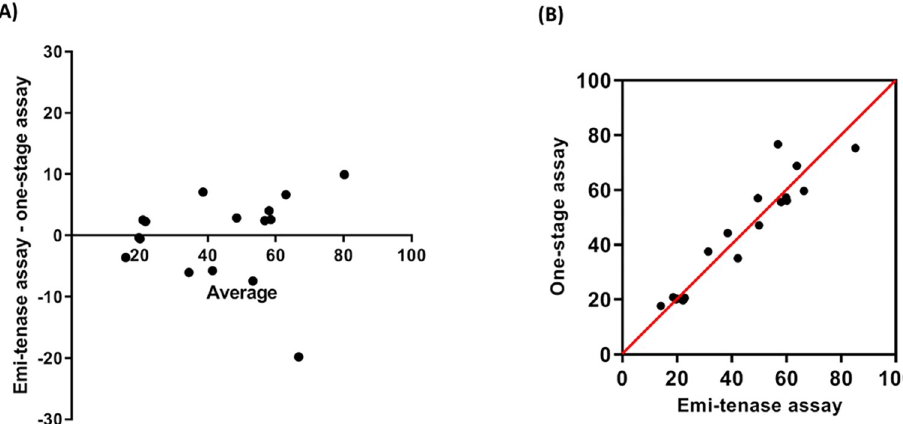
Fig 5. Method comparison of two measurements. Seventeen plasma samples from hemophilia patients receiving emicizumab were subjected to APTT-based one-stage assay and Emi-tenase assay. (A) The Bland-Altman agreement analysis was done by plotting the difference of the two paired measurements (Emi-tenase assay–one-stage assay) against the mean of those two measurements. (B) A scatter plot of the relationship between measured values of the same samples using both